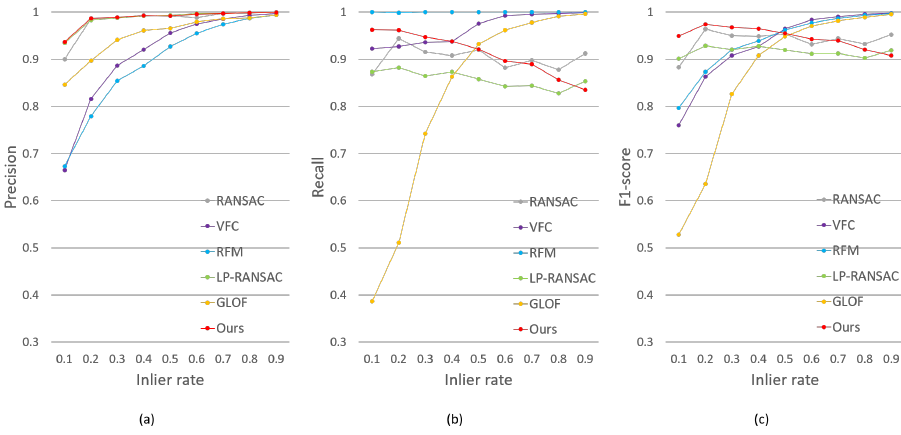
Figure 7. Matching accuracy performance comparison of the considered six methods for the “Small Village” dataset. ( a ) For precision. ( b ) For recall. ( c ) For F1-score.